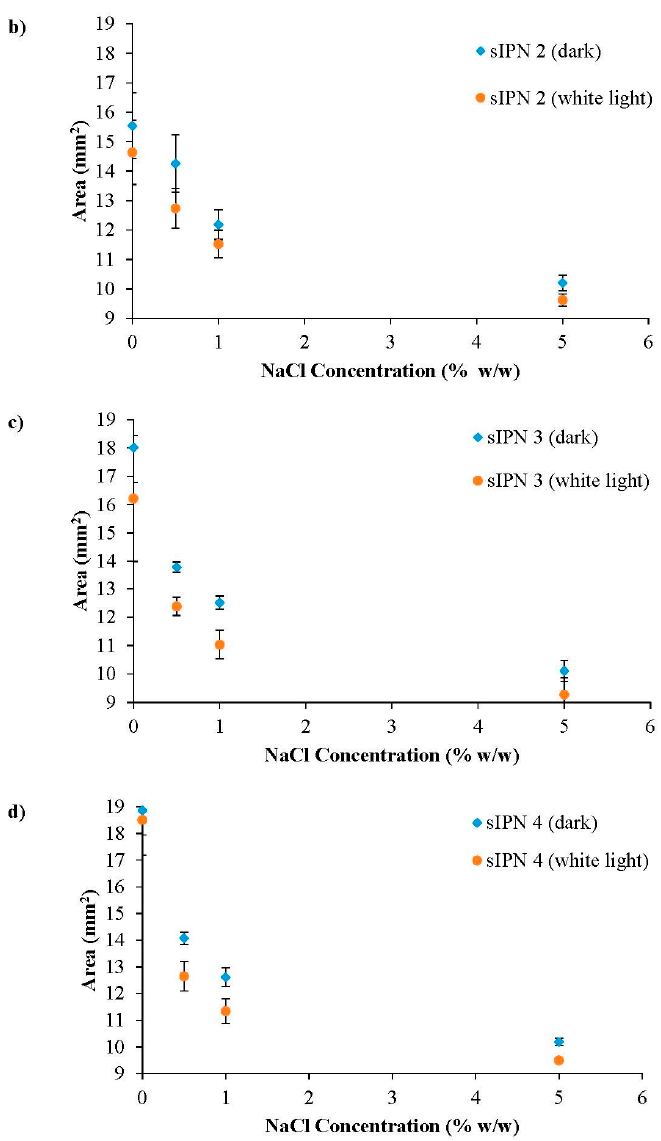
Figure 8. White-light and ionic strength induced shrinking of the hydrogels. ( a ) sIPN 1; ( b ) sIPN 2; ( c ) sIPN 3; ( d ) sIPN 4.